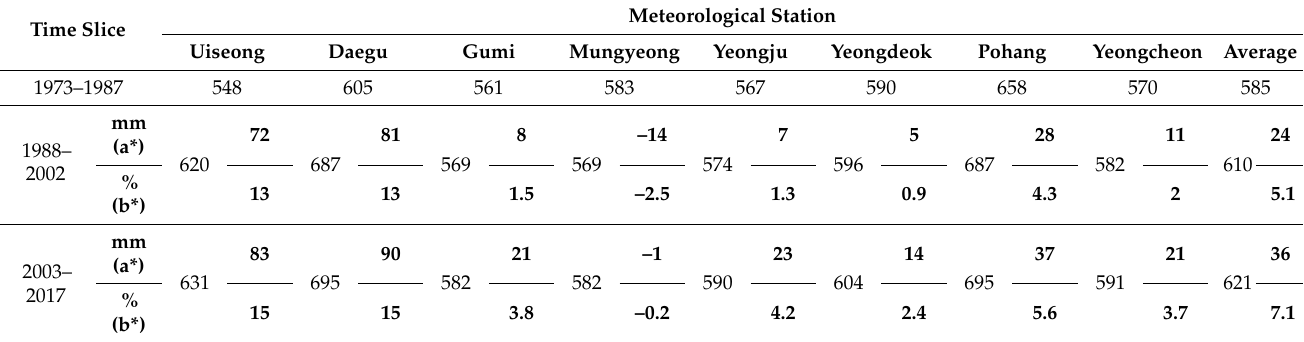
Table 6. Average seasonal cumulative ET c of rice during TS1 (1973–1987), TS2 (1988–1902), and TS3 (2003–2017) based on the daily data from the selected meteorological stations. The bold values show the absolute and percent change in rice ET c during the TS2 and TS3 compared to the